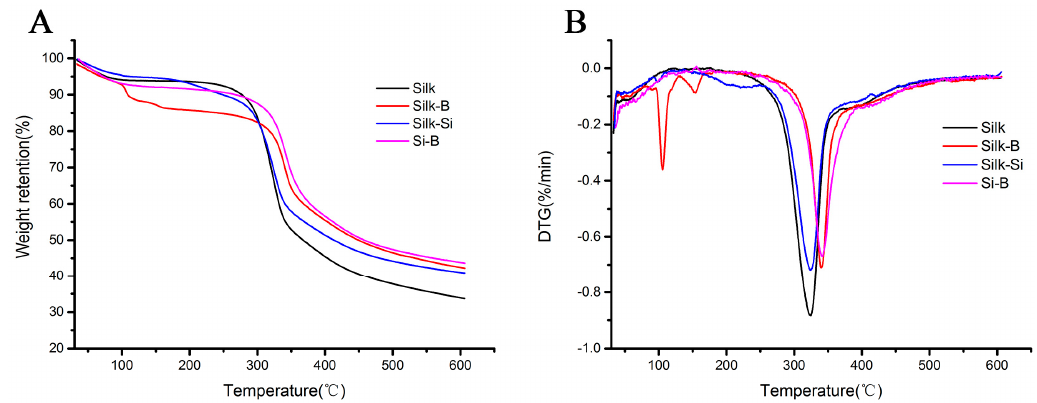
Figure 6. TG ( A ) and DTG ( B ) curves of Silk and Silk-B, Silk-Si and Si-B samples in nitrogen atmosphere.